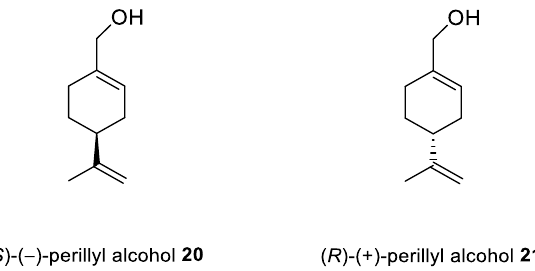
Figure 9. Stereoisomers of perillyl alcohol.